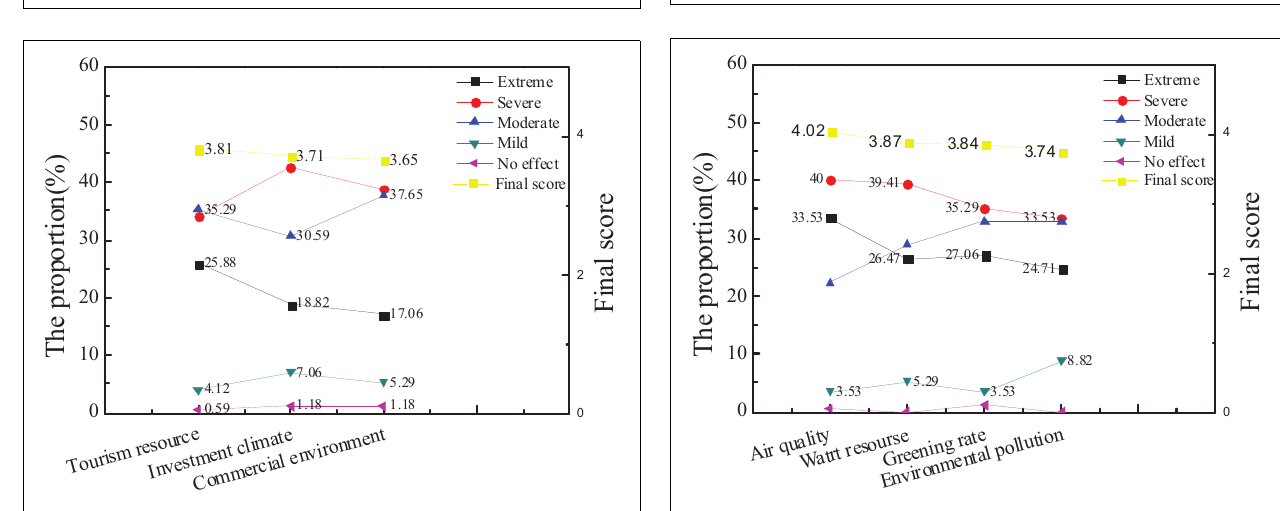
FIGURE 11 | Comparison between the average scores of new entrepreneurs and the overall audience.